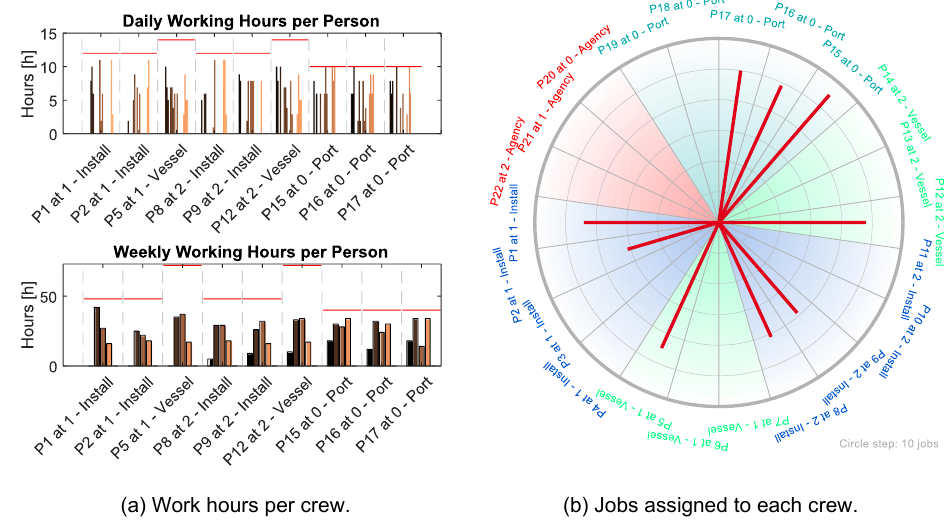
Figure 5. Exemplary results for the scenario July 2000 with two